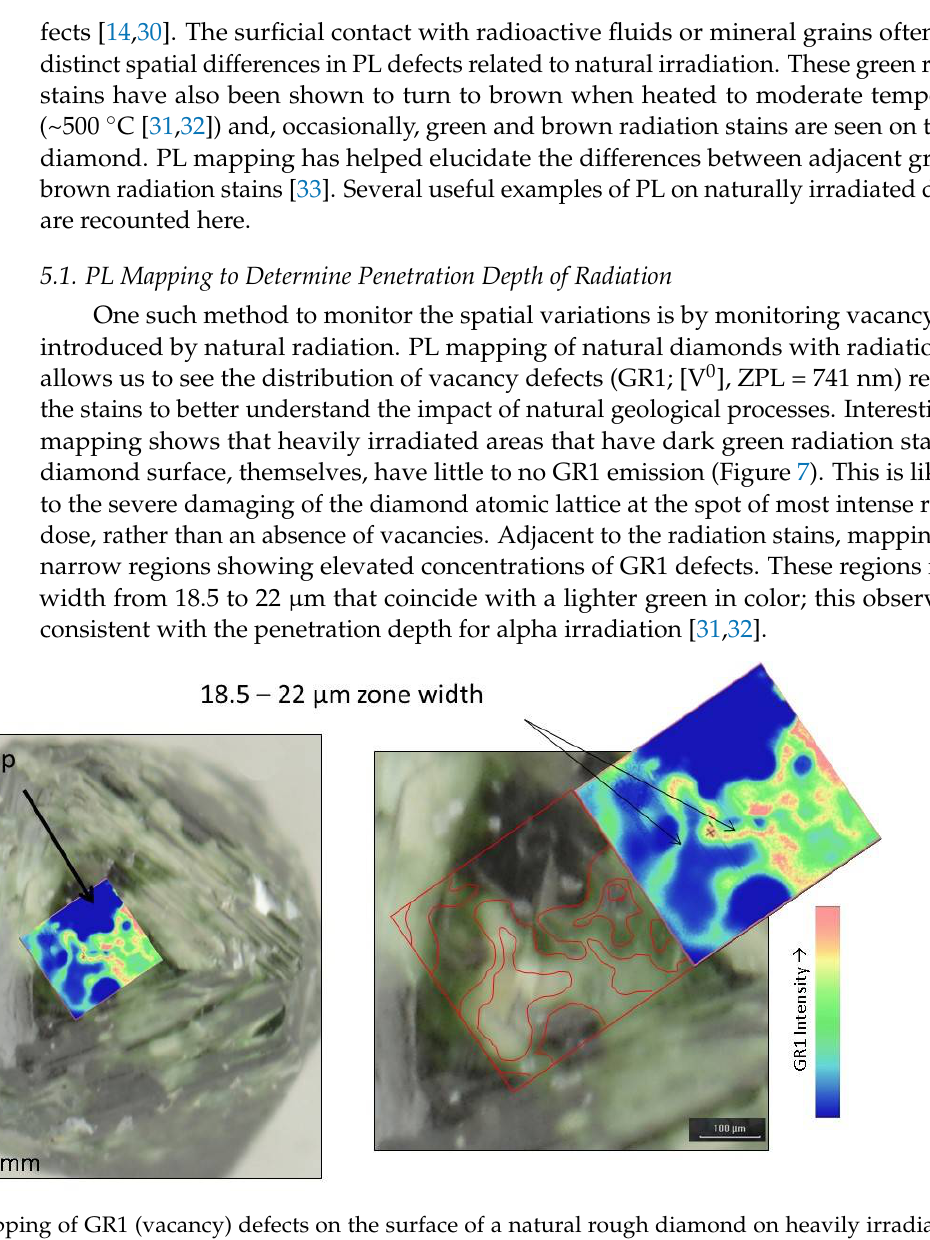
Figure 7. ( Left ) PL mapping of GR1 (vacancy) defects on the surface of a natural rough diamond on heavily irradiated areas that show dark green stains and ~20 µm narrow adjacent zones of GR1. ( Right ) A higher magnification version of the left image shows an overlay of the regions with high GR1 (box with red outlines) along with the corresponding PL map, which is displaced in order to show the radiation features underneath. The arrows are indicating a few examples of the narrow regions with elevated GR1 concentration and have a width of 18.5–22 µm, consistent with the penetration depth for alpha irradiation.